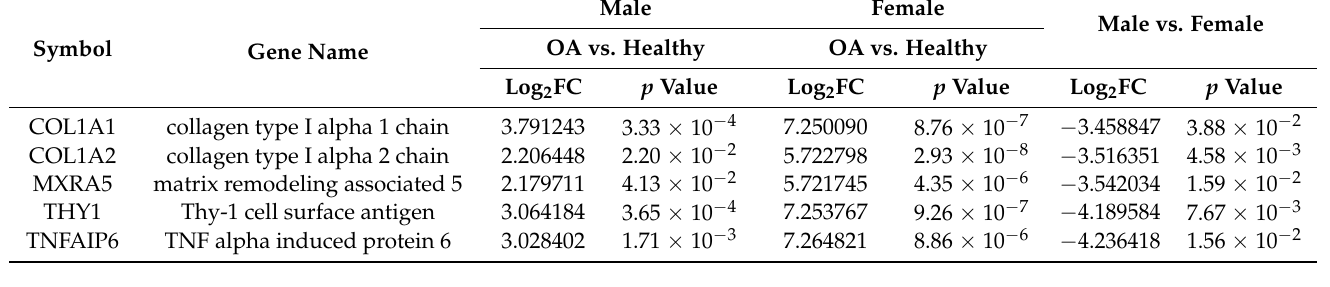
Table 4. Genes with different multiples of change in females and males.